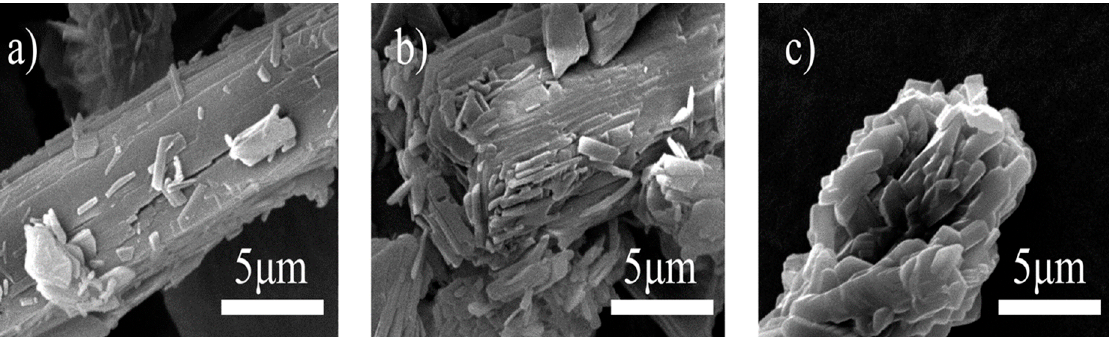
Figure 8. SEM pictures of theophylline: ( a ) Form III crystals (before transition), ( b ) Half way during transition, ( c ) Form II crystals (after transition). Reprinted (adapted) with permission from [62]. Copyright 2007, American Chemical Society.